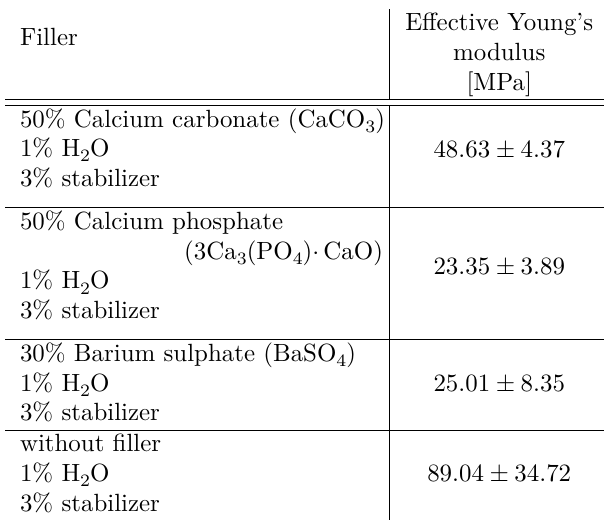
Table 2. Average of the effective Young’s modulus of the